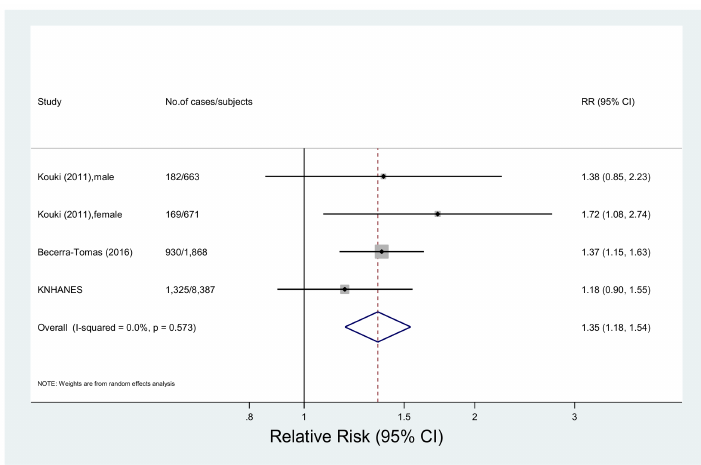
Figure 4. Forest plot of observational studies of metabolic syndrome for the highest vs. lowest levels of processed meat consumption, using a random-effects model.